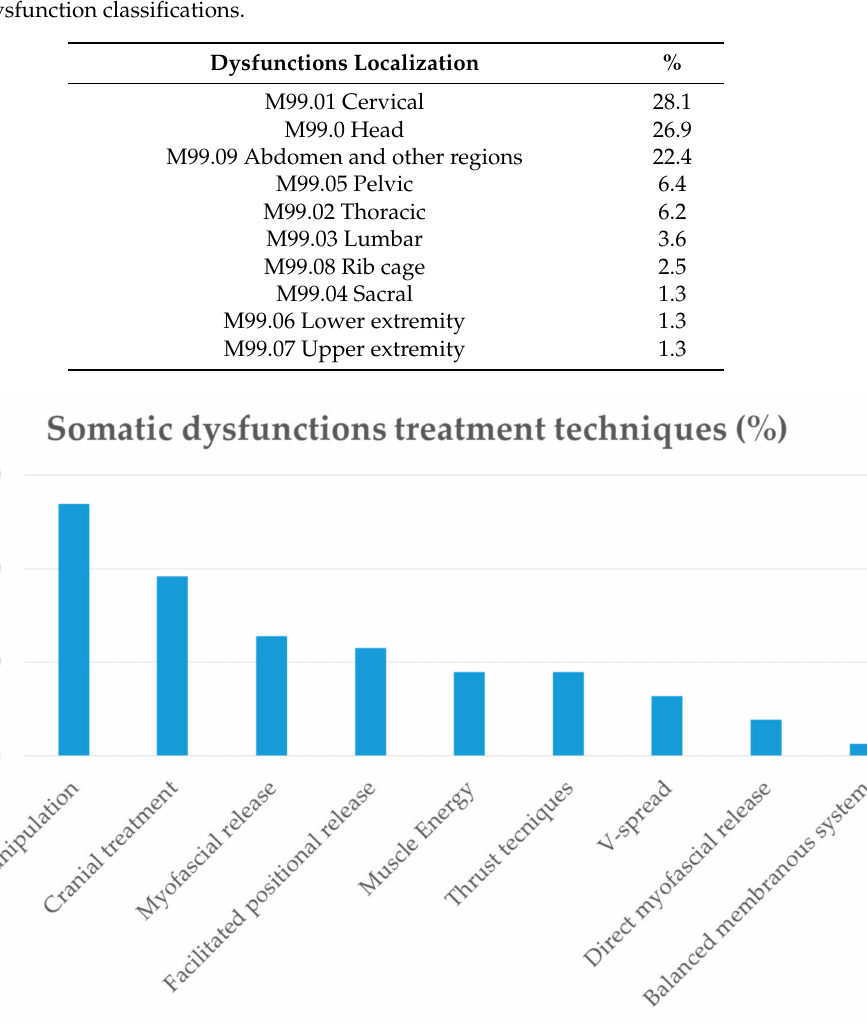
Figure 2. Somatic dysfunction treatment techniques